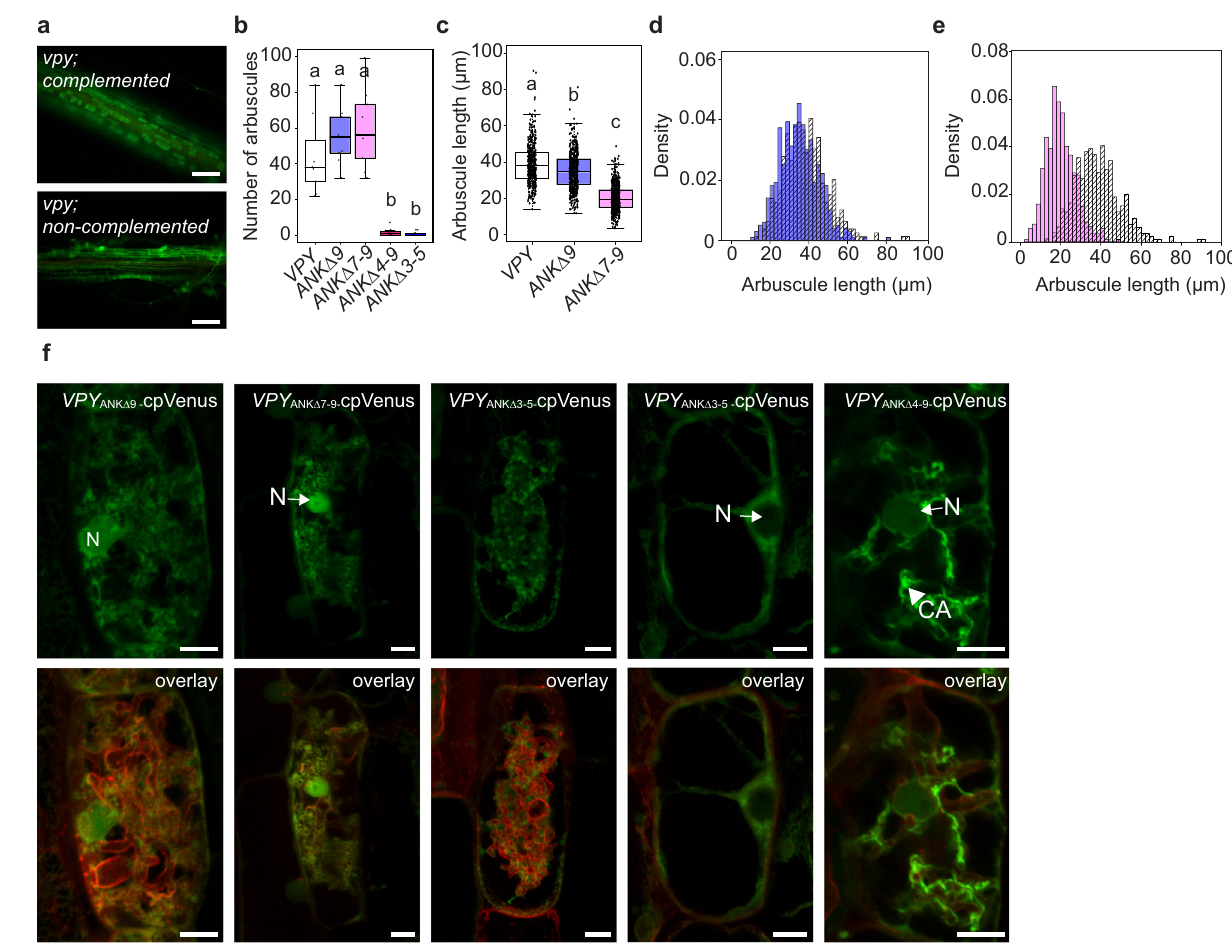
Fig. 2 | Broadscale ankyrin deletion analysis. a – e vpy-4 was transformed with VPY pro :VPY-cpVenus or ankyrin deletion constructs, colonized with Diversispora epigeae ,andharvested4weekspostplanting.Rootswerestainedwithwheatgerm agglutinin conjugated to AlexaFluor 488 (WGA-AlexaFluor 488) to visualize the fungus. a Representative epi fl uorescence images of vpy-4 WGA-AlexaFluor 488 stained roots complemented with VPY pro :VPY-cpVenus , ornot complemented, as seen for vpy-4 transformed with VPY pro :VPY ANK Δ 3-5 -cpVenus . Scale bars, 100 μ m. b Number of arbuscules per infection unit in vpy-4 transformed with ankyrin deletion constructs. Different letters indicate statistically signi fi cant differences using one-way ANOVA, p <0.05, n =9 infection units, sampled from three biolo- gical replicates with three infection units per biological replicate. c Arbuscule length of vpy-4 transformed with VPY pro :VPY-cpVenus ( n =396 arbuscules) , VPY pro :VPY ANK Δ 9 -cpVenus ( n =496 arbuscules), or VPY pro :VPY ANK Δ 7-9 -cpVenus ( n =536 arbuscules). Different letters signify statistically signi fi cant differences from one-way ANOVA, sampled from three biological replicates with three infec- tion units per replicate. In ( b ) – ( d ), lines in boxplots represent the median value, boxlimitsrepresenttheupperandlowerquartiles,whiskersrepresent1.5timesthe interquartile range. d Overlapping histogram of arbuscule length between